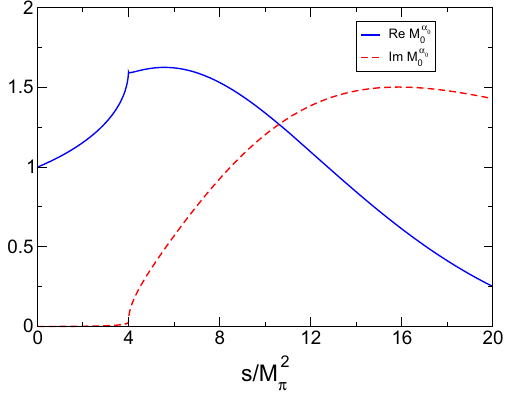
Fig. 7 Solution of the isospin zero amplitude. Notation as in Ref.